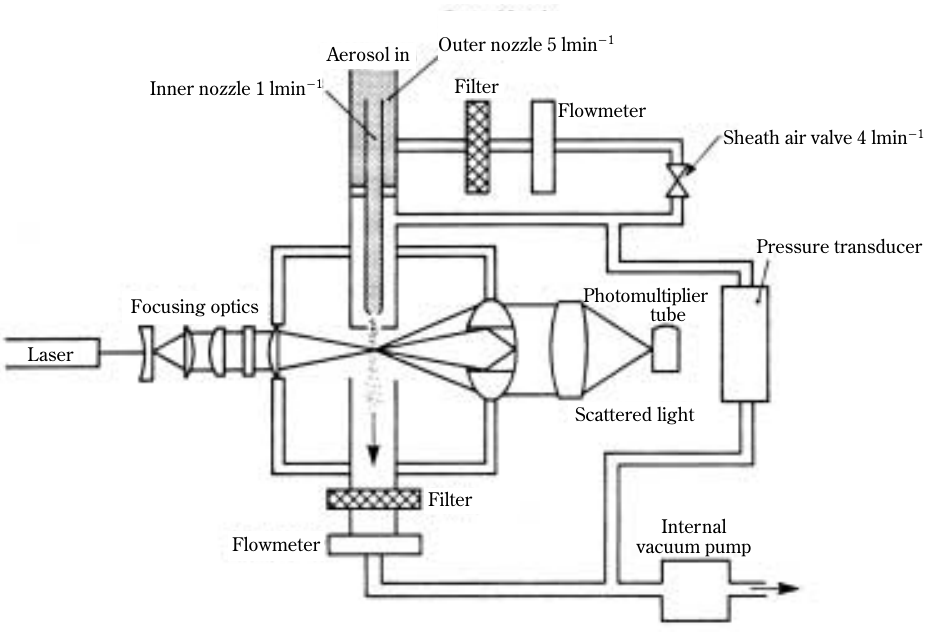
Fig. 7 Aerosol flow path and TOF detection system for the models 3300 and 3310 APS ® aerodynamic particle sizer spectrometer (courtesy TSI